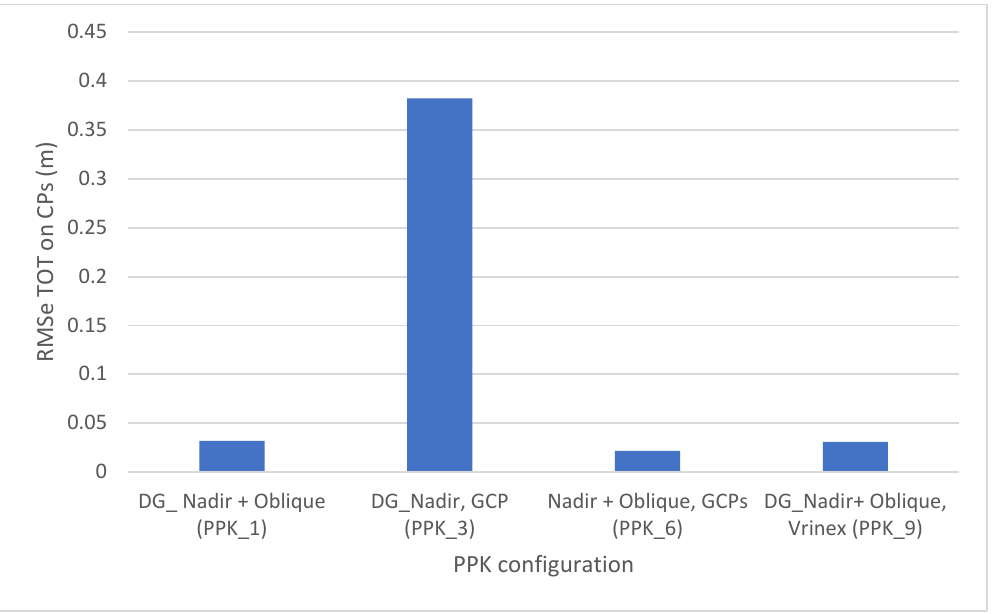
Table 12. PPK approach. RMSE on CPs for configuration from PPK_10 to PPK_15.